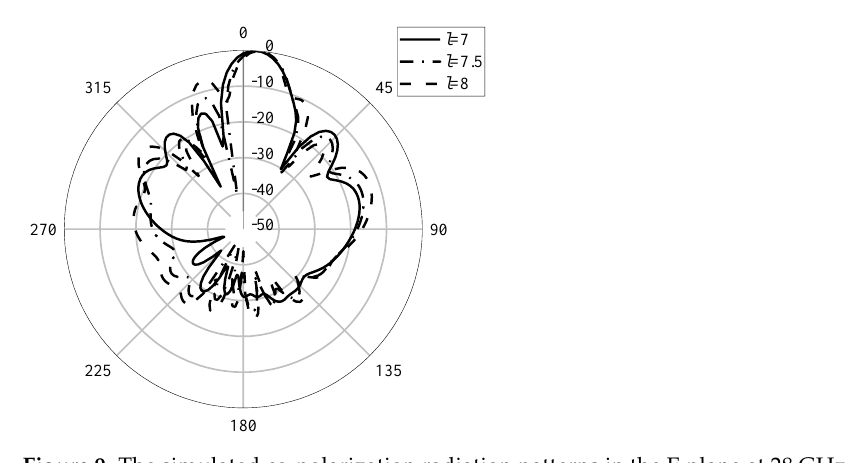
( b ) Figure 10. Fabricated 5 × 5 interconnected ME dipole antenna array. The ( a ) fabricated prototype and ( b ) antenna under test. Figure 11 shows the simulated and measured |S 11 |, which are in good agreement. The simulated and measured − 10 dB impedance bandwidths are 11.9 GHz (or 42.5% at 28 GHz) from 22.7 to 34.6 GHz and 14.5 GHz (or 52% at 28 GHz) from 21.5 GHz to 36 GHz, respectively. The discrepancy between the simulated and measured |S 11 | is mainly due to the effect of fabrication tolerance and the soldering. Figure 12 plots the simulated and measured peak realized gain and efficiency. The simulated and measured maximum re- alized gains are 20.85 dBi at 28 GHz and 20.44 dBi at 27.5 GHz, respectively. The simulated and measured 3 dB gain bandwidths are 3.65 GHz (or 13% at 28 GHz) from 26.18 GHz to 29.69 GHz and 3.5 GHz from 26.25 GHz to 29.75 GHz (or 12.5% at 28 GHz), respectively. By comparing the measured gain and the simulated directivity, the radiation efficiency of the proposed antenna array is 79.25% at 28 GHz. The simulated and measured radiation patterns are shown in Figure 13. The main beams of the radiation patterns are in the